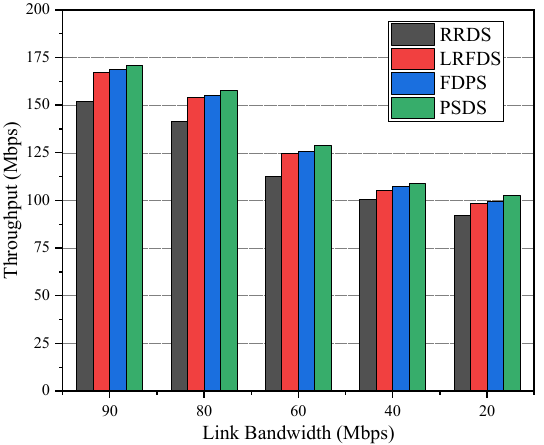
Figure 9. Average throughput under di ff erent bandwidths.